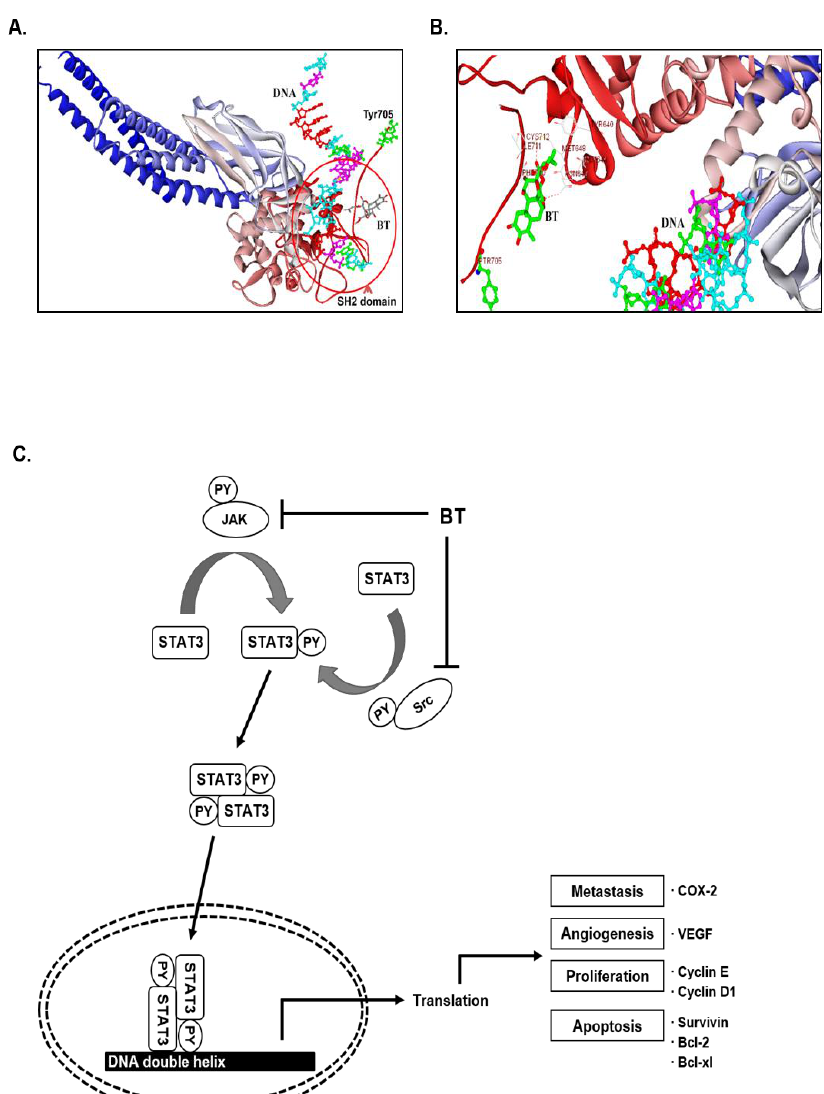
Figure 5. In silico interaction analysis between the SH2 domain of STAT3 and BT. ( A ) Surface view of STAT3β homodimer (PDB ID: 1BG1). ( B ) An interaction map of the SH2 domain of STAT3 with of STAT3 β homodimer (PDB ID: 1BG1). ( B ) An interaction map of the SH2 domain of STAT3